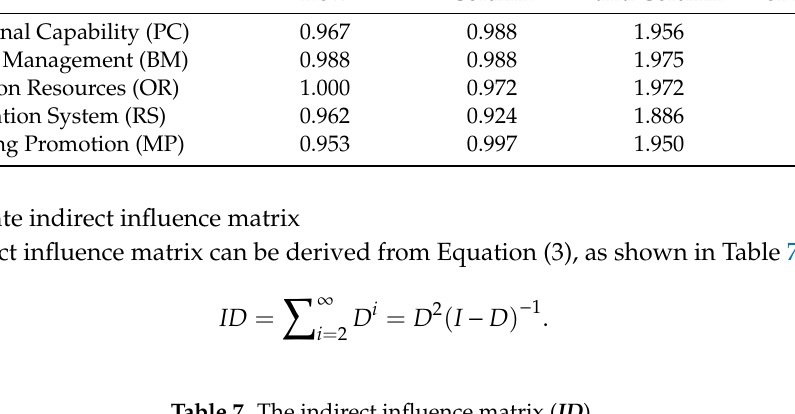
Table 7. The indirect influence matrix ( ID